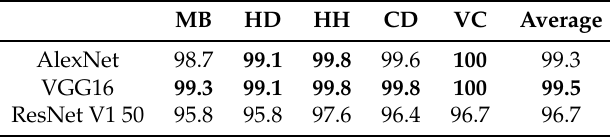
Table 2. Type classification accuracy (%) with the three CNNs.